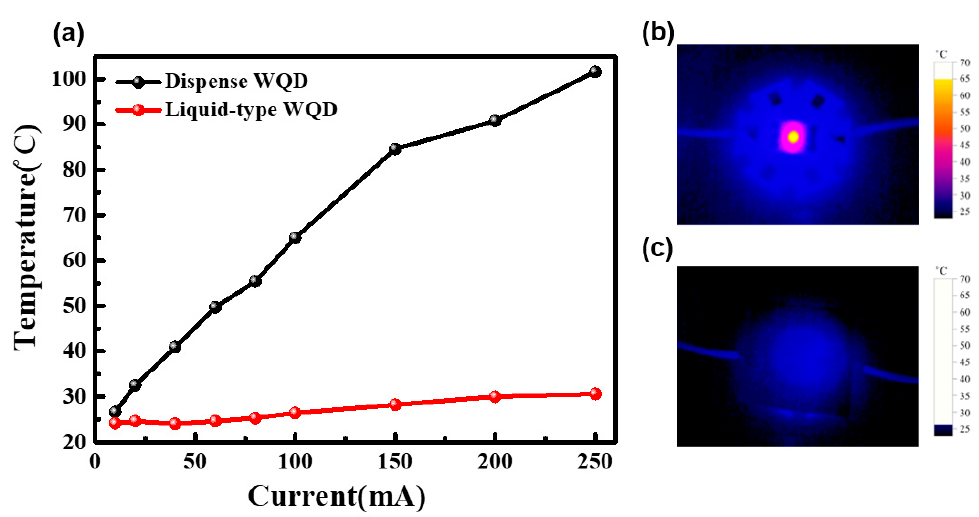
Figure 4. ( a ) Surface temperature of RWQD-WLED and LWQD-WLED. ( b ) IR images of surface temperature image of RWQD-WLED and ( c ) LWQD-WLED at 100 mA driving current.